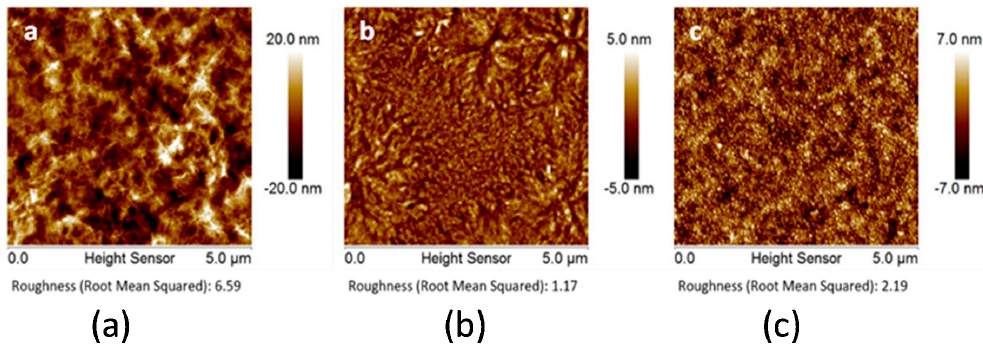
Figure 3. Representative atomic force microscopy (AFM) images of about 50–180 nm thick spin-coated films of ( a ) cellulose (CL), root mean square (RMS) roughness is 6.59 nm; ( b ) nylon, RMS roughness